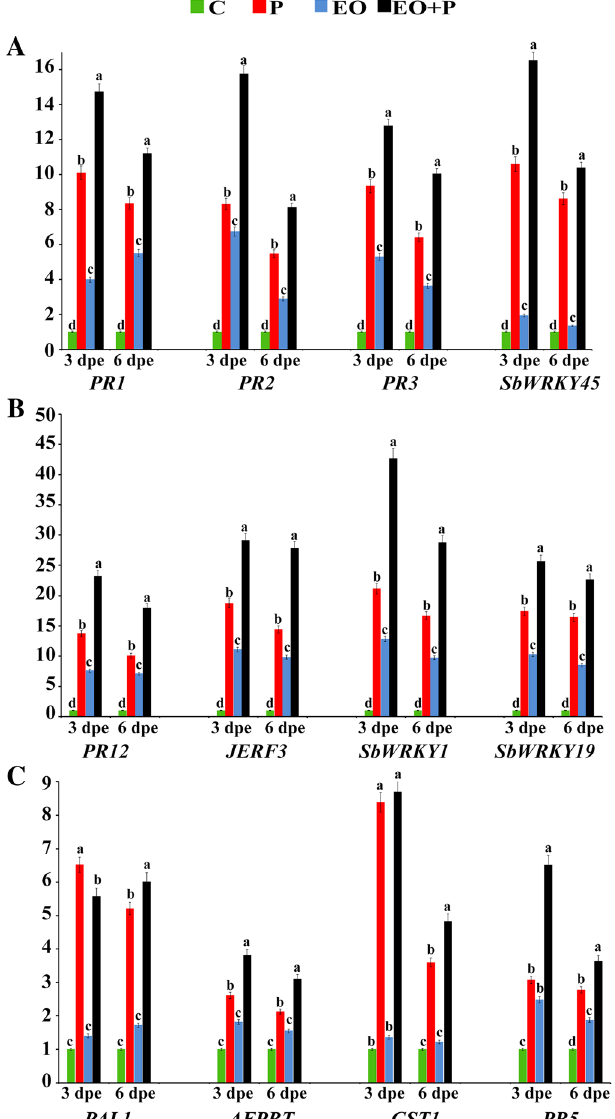
Figure 5. Histograms showing relative transcriptional expression levels of three SbWRKY transcription factors and some defense-related genes in sorghum plants infected with Fusarium solani and/or treated with lavender essential oil at 1.5% after 3 and 6 days post-emergence (dpe). C: untreated control, P: infected with F. solani , EO: treated with lavender essential oil at 1.5%, and P + EO: infected with F. solani and treated with lavender essential oil at 1.5%. In each time for each studied gene, columns superscripted with the same letter are not significantly different according to Duncan’s multiple range test ( P ≤ 0.05). Each value represents the mean of three biological replicates; each sample was analyzed in triplicate. Error bars represent standard